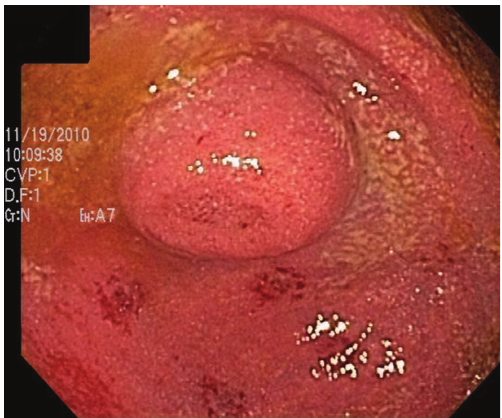
Figure 3: Protuberance at the appendiceal orifice seen at colono- scopy in Case 2.